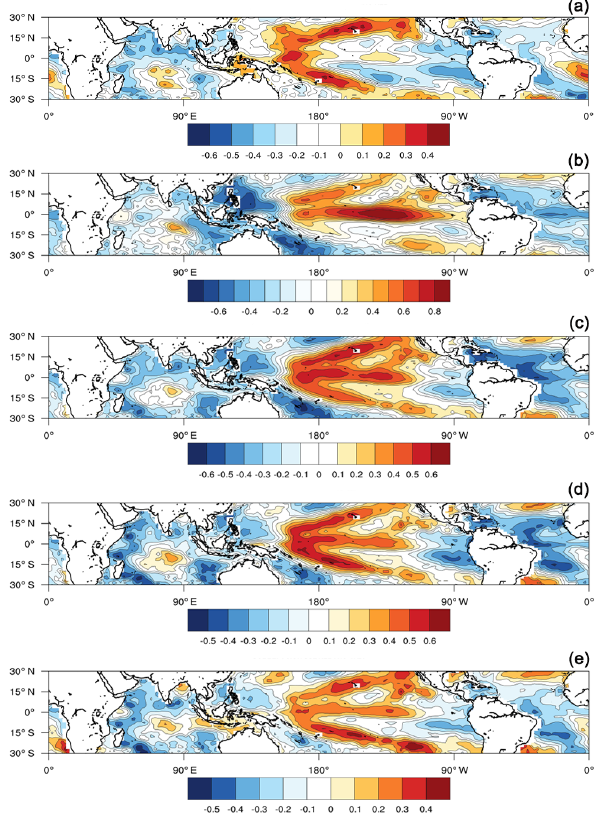
Figure 5. (a) The spatial pattern (EOF) associated with the 15th PC of the SST field used for the prediction of the summer Niño3.4 In- dex. (b) and (c) represent the spatial pattern (EOF) associated with the 3rd PC and the 5th PC, respectively, of the GSE MTT field that was also used for those predictions. Notice the propagation of fea- tures between (b) and (c) .